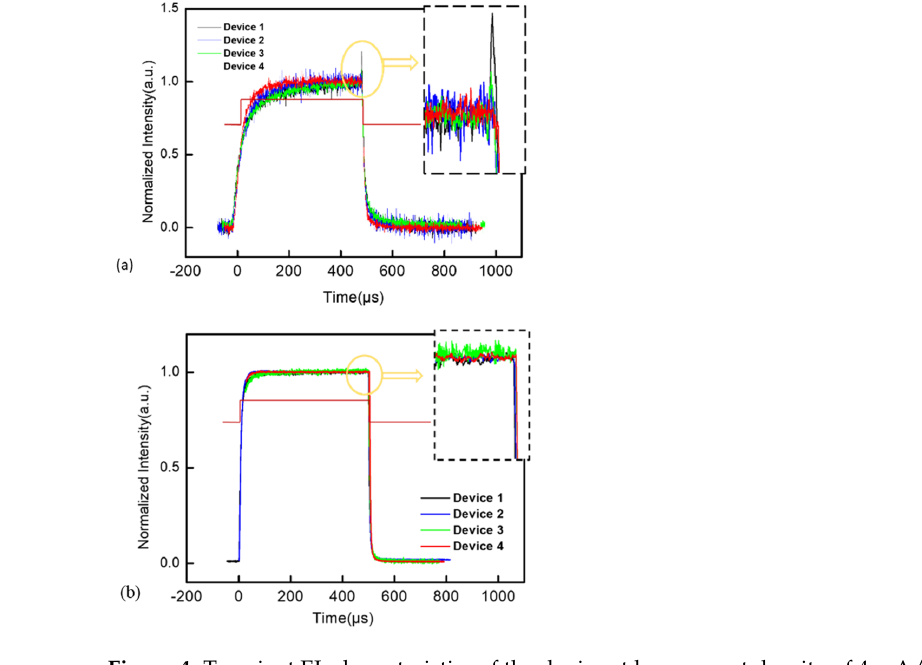
Figure 4. Transient EL characteristics of the device at low current density of 4 mA/cm 2 ( a ) and high current density of 40 mA/cm 2 ( b